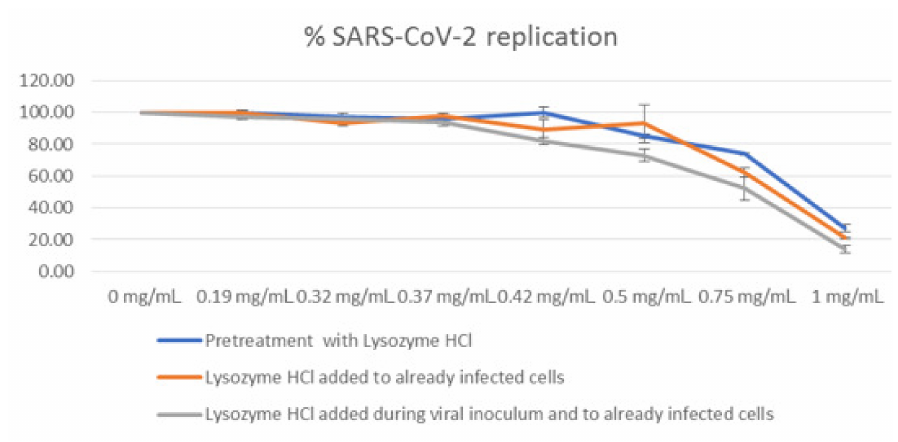
Figure 2. Antiviral activity of lysozyme HCl against SARS-CoV-2, expressed as percentage of viral